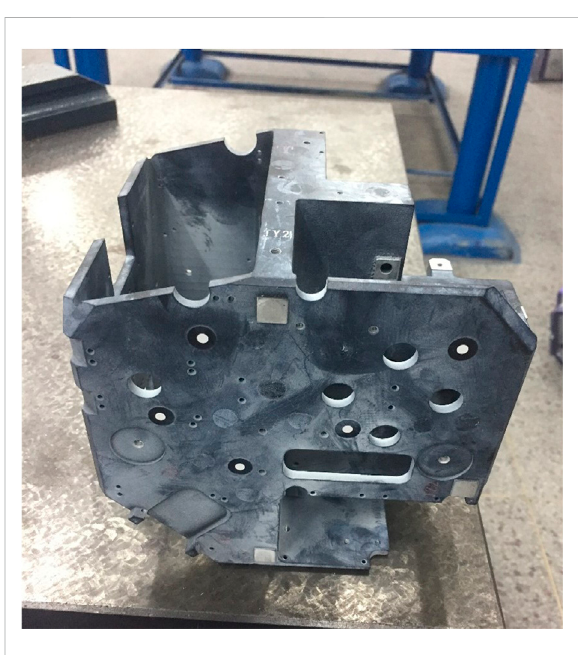
FIGURE 5 Schematicdiagramoftheprecisionmachinedworkpieceand pasting mark points.